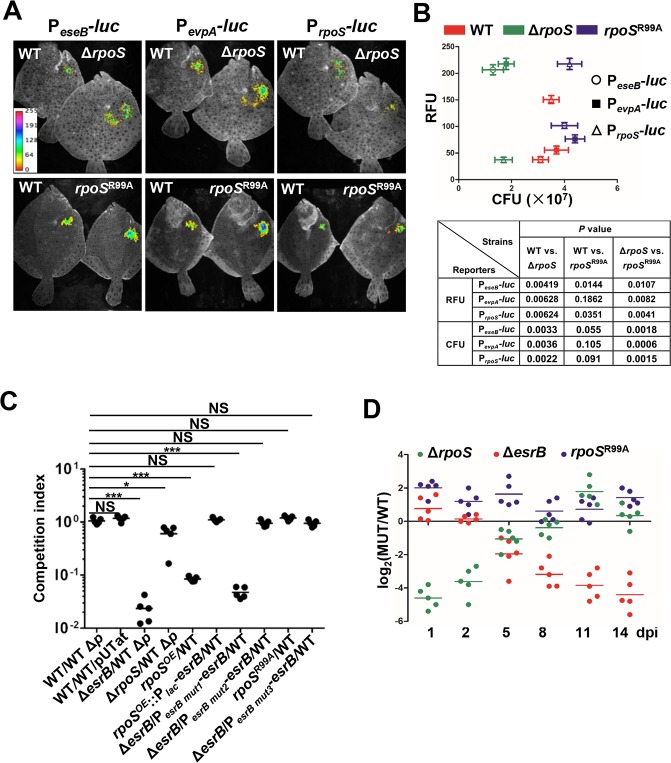
RpoS represses EsrB expression and colonization during infection of the fish.(A-B)
In vivo measurement of T3SS (eseB), T6SS (evpA) and rpoS gene expression using luminescence. The WT, ΔrpoS, and rpoSR99A strains harboring PeseB-, PevpA-, or PrpoS- luc reporter plasmids were inoculated into turbot and luminescence and bacterial burden was measured 8 dpi. The P values are based on the ANOVA analysis of the relative fluorescence units (RFU) and the bacterial burden in each fish (n = 3). (C)
In vivo competition assays for the ΔrpoS, ΔesrB, rpoSOE, and rpoSR99A strains vs the WT or WTΔp (WT with pEIB202 cured), which are Cm resistant or sensitive, respectively. The strains rpoSOE::Plac-esrB (rpoSOE constitutively expressing esrB driven by Plac), ΔesrB/PesrBmut1-esrB,ΔesrB/PesrBmut2-esrB, and ΔesrB/PesrBmut3-esrB (ΔesrB harboring plasmid pUTat expressing esrB driven by PesrBmut1, PesrBmut2, or PesrBmut3) were competed vs the WT. 1:1 mixtures of the indicated strains were i.p. administered into turbot and cultivated for 8 dpi before CFU in the liver were enumerated. *P < 0.01; **P < 0.001; ***, P<0.0001, based on ANOVA followed by Bonferroni’s multiple-comparison post-test to compare the data to the values for the corresponding WT/WTΔp samples. (D) Competitive indices of the indicated strains mixed with WT or WTΔp inoculated into fish and recovered at 1, 2, 5, 8, 11 and 14 dpi were performed as described in C (n = 5 per group).